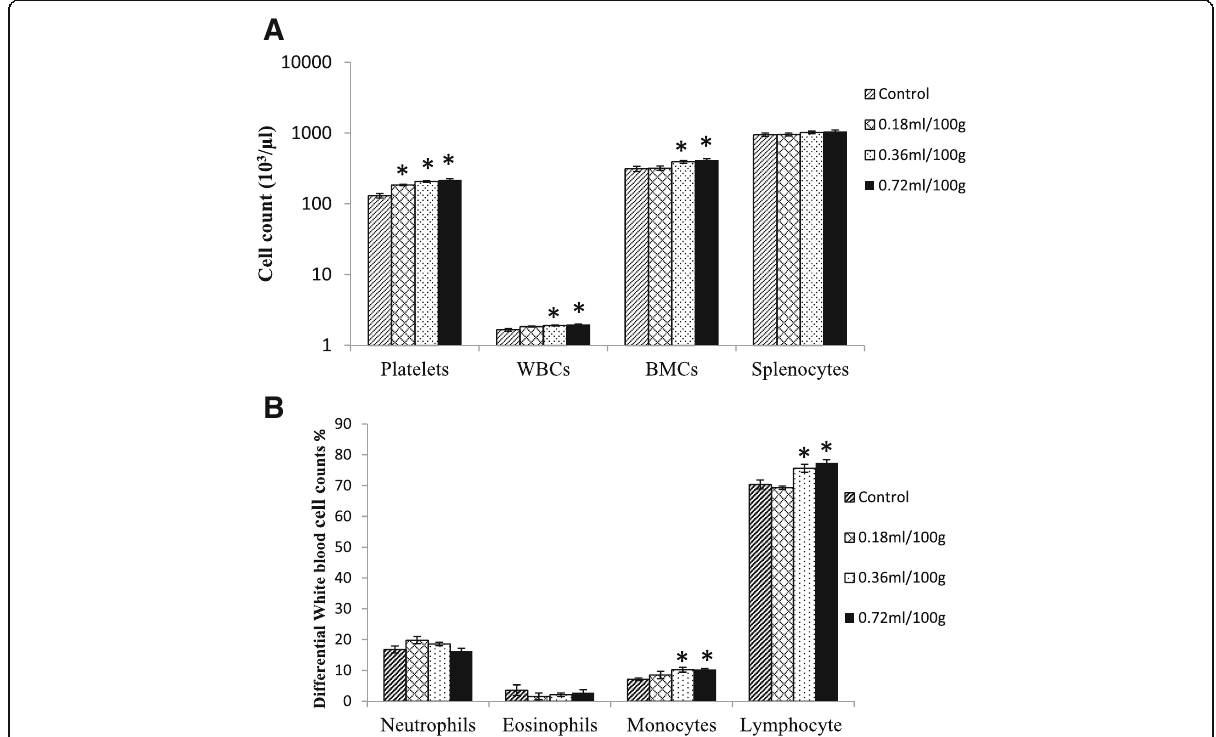
Fig. 1 Effect of the MLCC on a Enumeration of rat immune cells: platelets, total white blood cells, bone marrow cells, and splenocytes b Differential counts of rat peripheral leukocytes. Results are expressed as Mean ± SEM for the number of animals used ( n = 6). * p < 0.05 were considered significant when compared with the control (Mann Whitney U test)